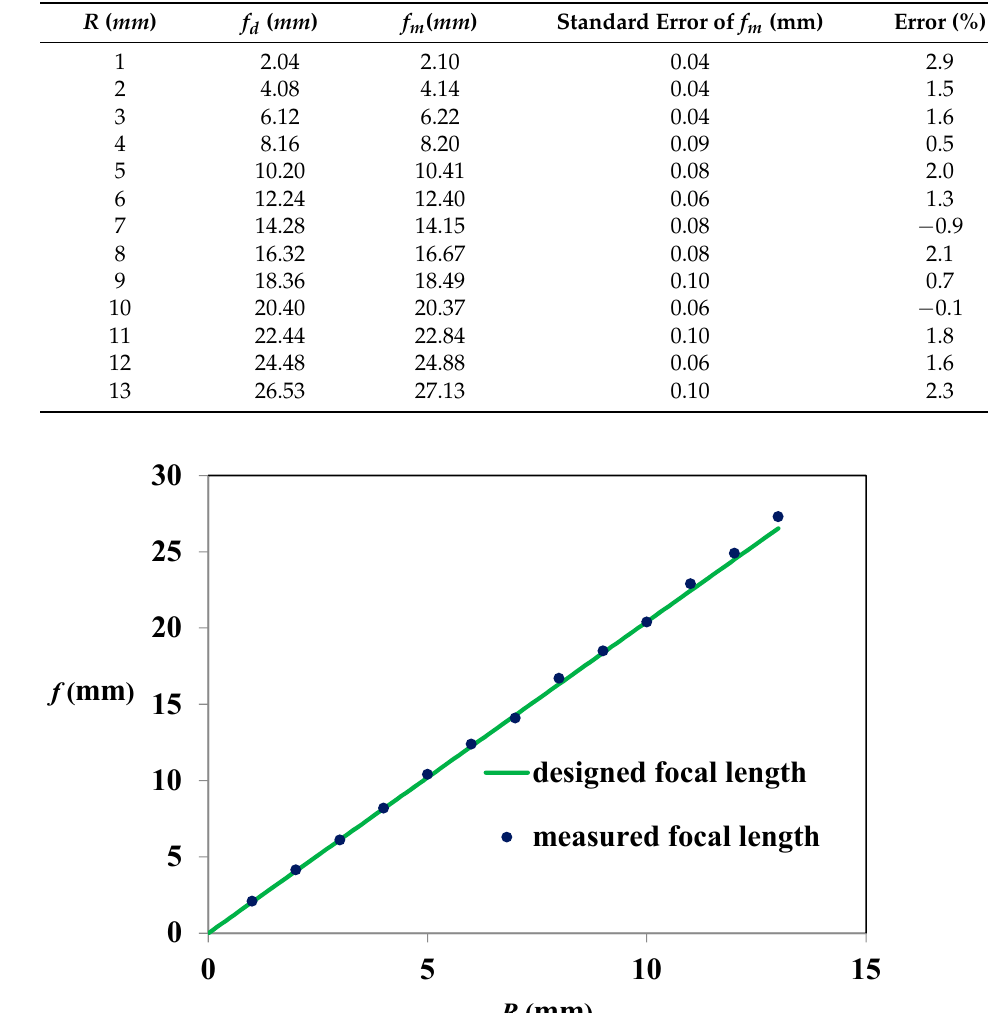
Table 1. Comparison of the measured and designed focal lengths, where R is radius of curvature, f d is the designed focal length, and f m is the measured focal length respectively.